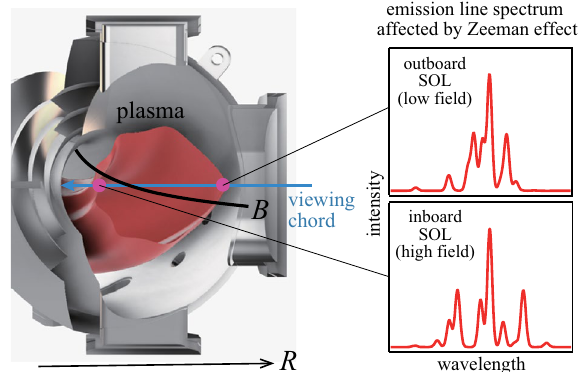
Figure 1. Schematic of typical observation geometry for diagnostics (ii). The illustrated spectra are those of HeI 2 3 S-2 3 P at 1 and 2 T observed in the direction perpendicular to the magnetic field without resolving